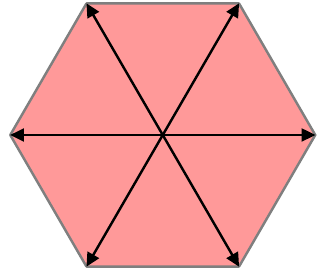
Figure 5. AV 2 R of the proposed MPC method.